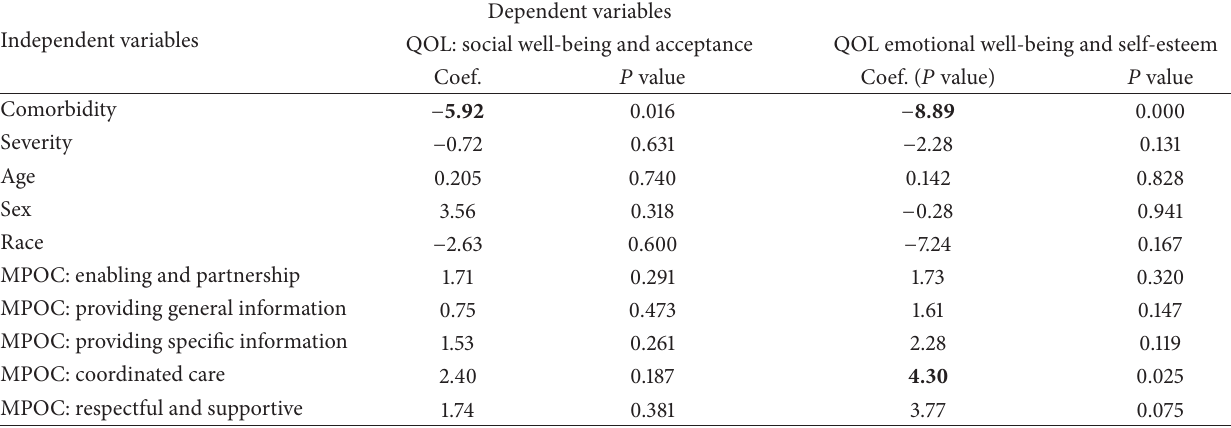
Table 3: Univariate linear regressions of each individual patient characteristic and MPOC score on each of the two psychosocial QOL